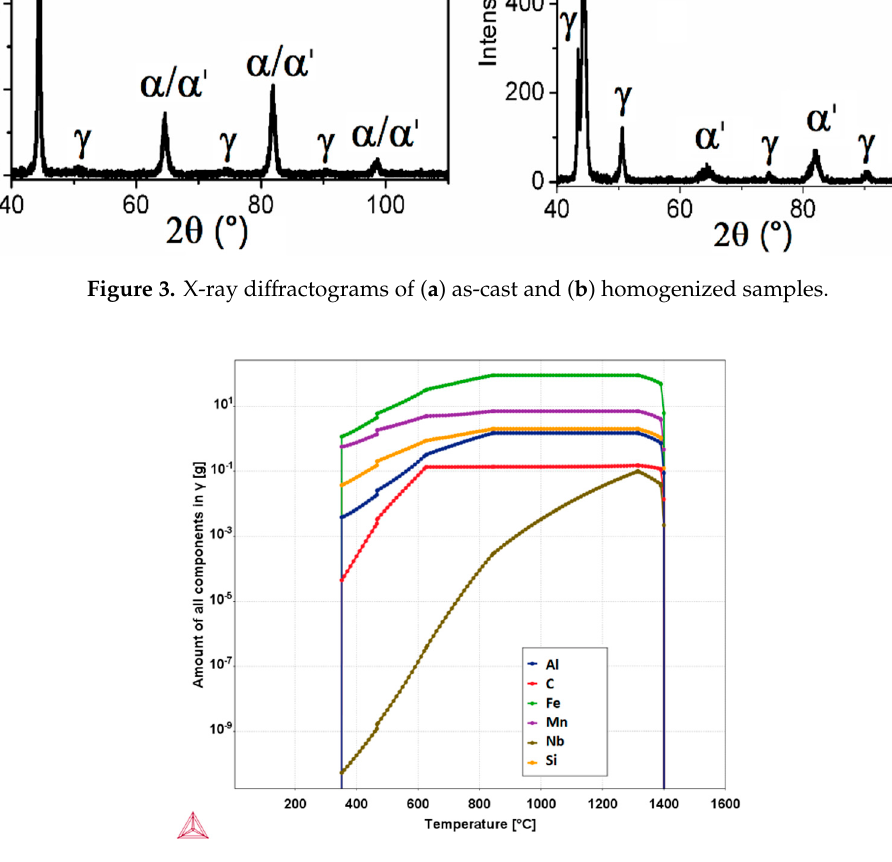
Figure 4. Distribution of alloying elements in the austenite matrix as a function of temperature.